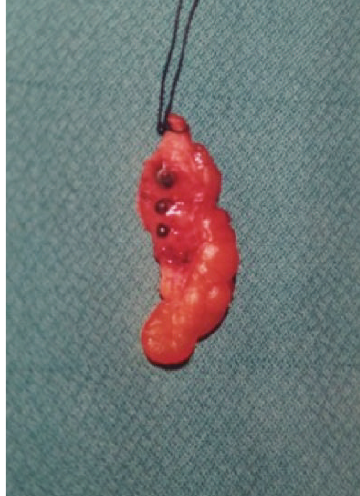
Figure 2: Three lead pellets within the appendix vermiformis.